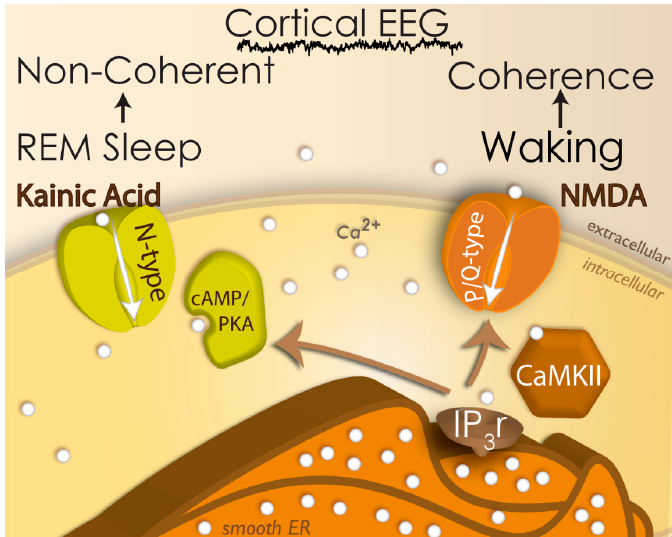
Figure 1. Two states, two channels, two types of gamma EEG. N-type calcium channels (green) are triggered by kainic acid to elicit gamma oscillations during rapid eye movement (REM) sleep, and these channels are modulated by the cAMP/PKA intracellular pathway (green). Gamma oscillations during REM sleep lead to the lack of coherence across distant cortical sites. On the other hand, P/Q-type calcium channels (brown) are triggered by NMDA to induce gamma oscillations during waking, and these channels are modulated by the Ca 2+ -calmodulin kinase II (CaMKII) intracellular pathway (brown). Both intracellular pathways affect calcium release into the cytoplasm by IP3 receptors in the endoplasmic